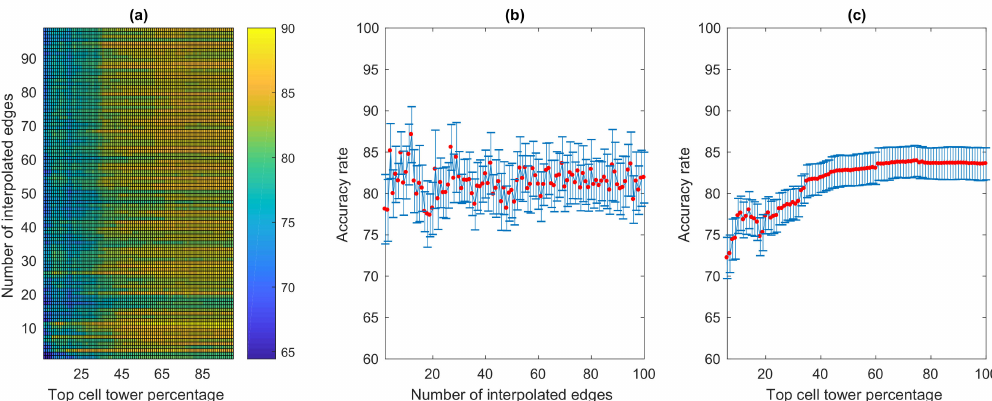
Figure 19. Overall results based on the interpolation-based method with commuting radius-based noise filtering; ( a ) accuracy rates, ( b ) average accuracy rates with varying numbers of interpolated edges, and ( c ) average rates with varying percentages of top cell